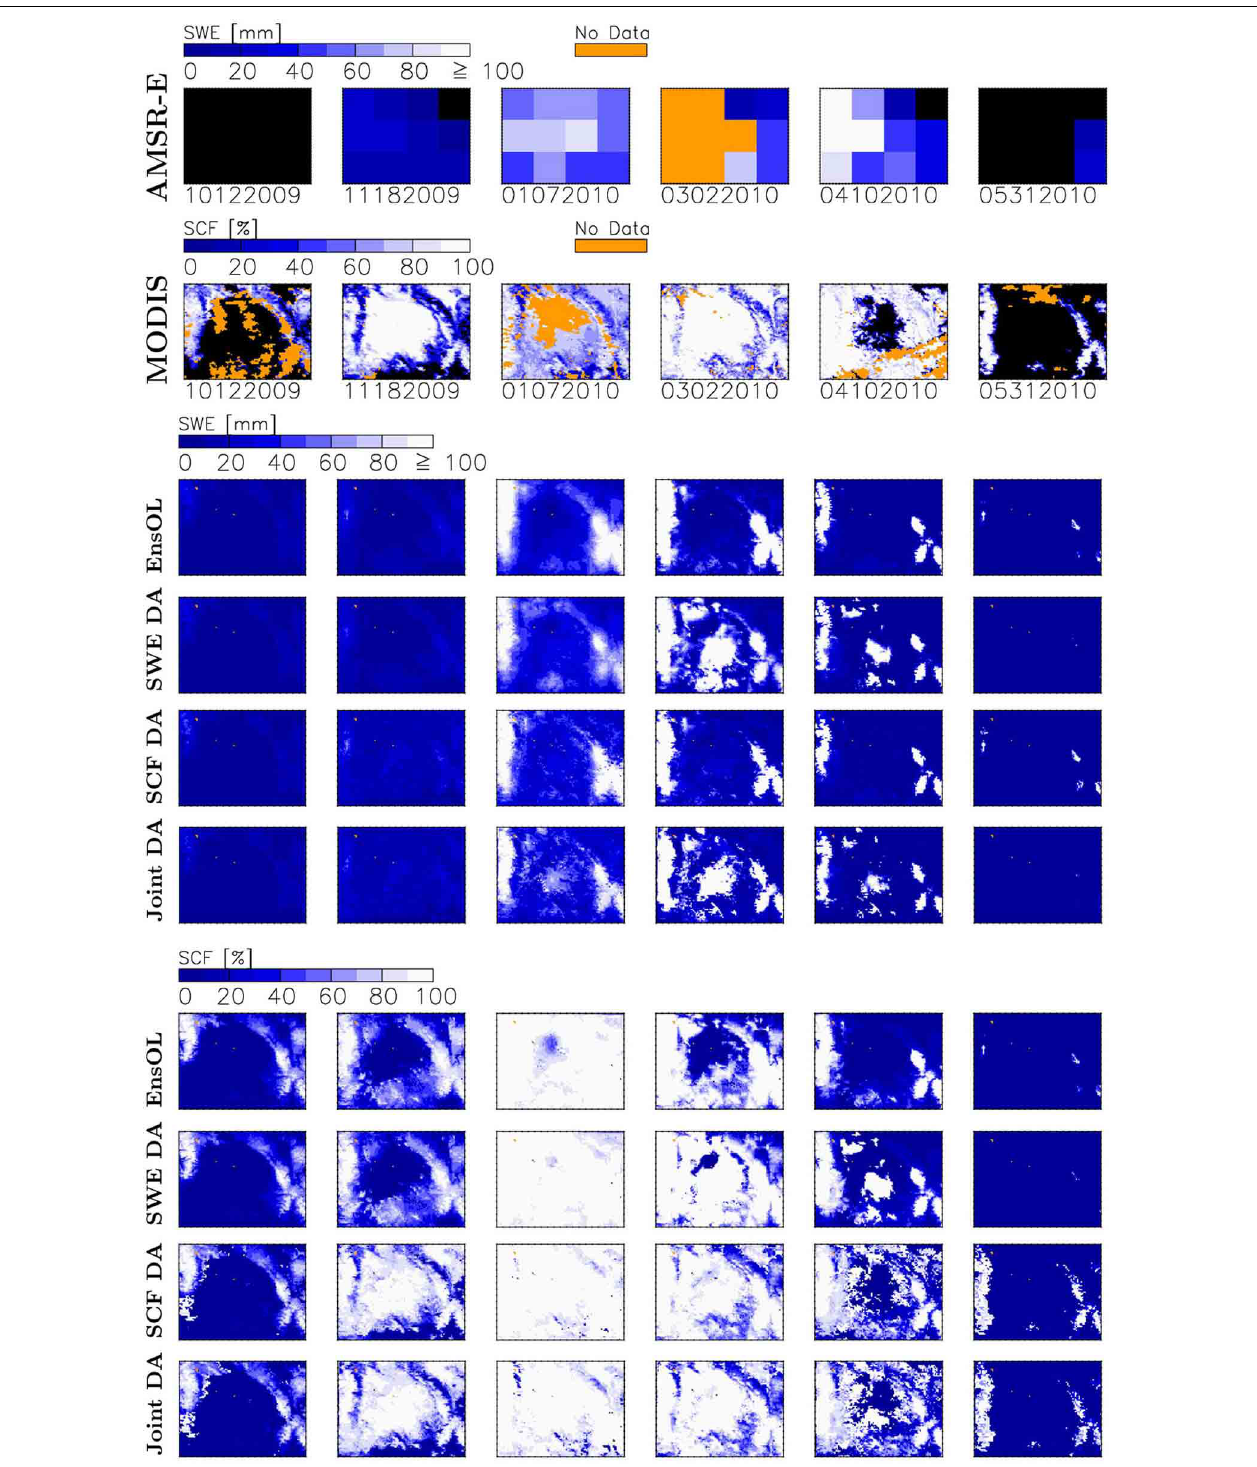
FIGURE 8 | Snow water equivalent, SWE (at 08:00 UTC) and snow cover fraction,SCF(at17:00UTC)fieldsfor5days(MMDDYYYY)inthewinterof 2009–2010. Nosnowisindicatedasblack.Thetop2rowsshowindividualSWE and SCF satellite observations. The remaining rows show SWE (at 09:00 UTC—block of middle four rows) and SCF (at 18:00 UTC—block of bottom four